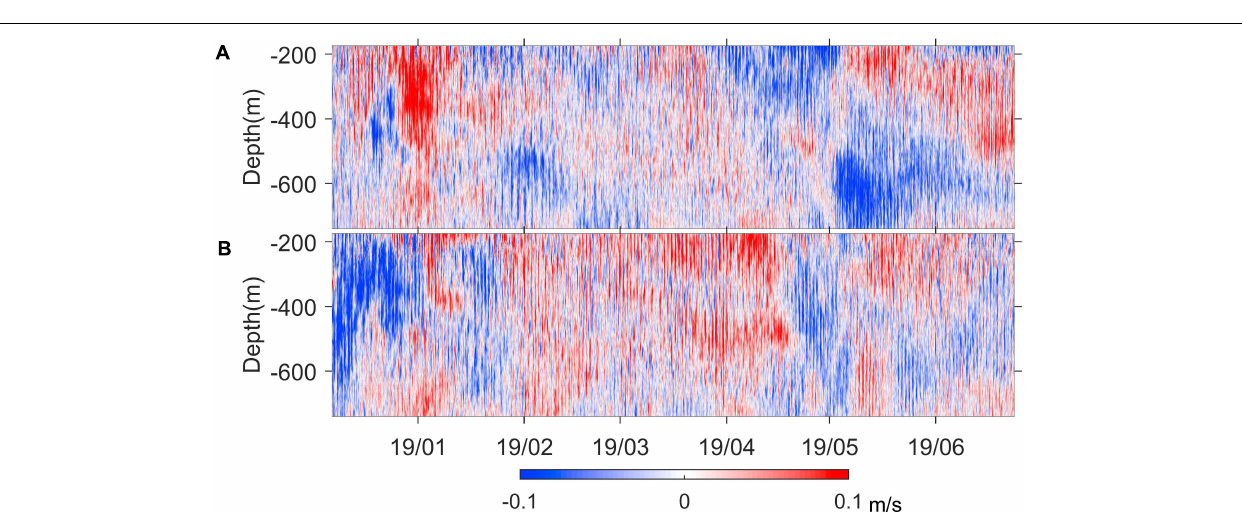
FIGURE 2 | Time series of the meridional (A) and zonal (B) components of current velocity (m/s) at the mooring